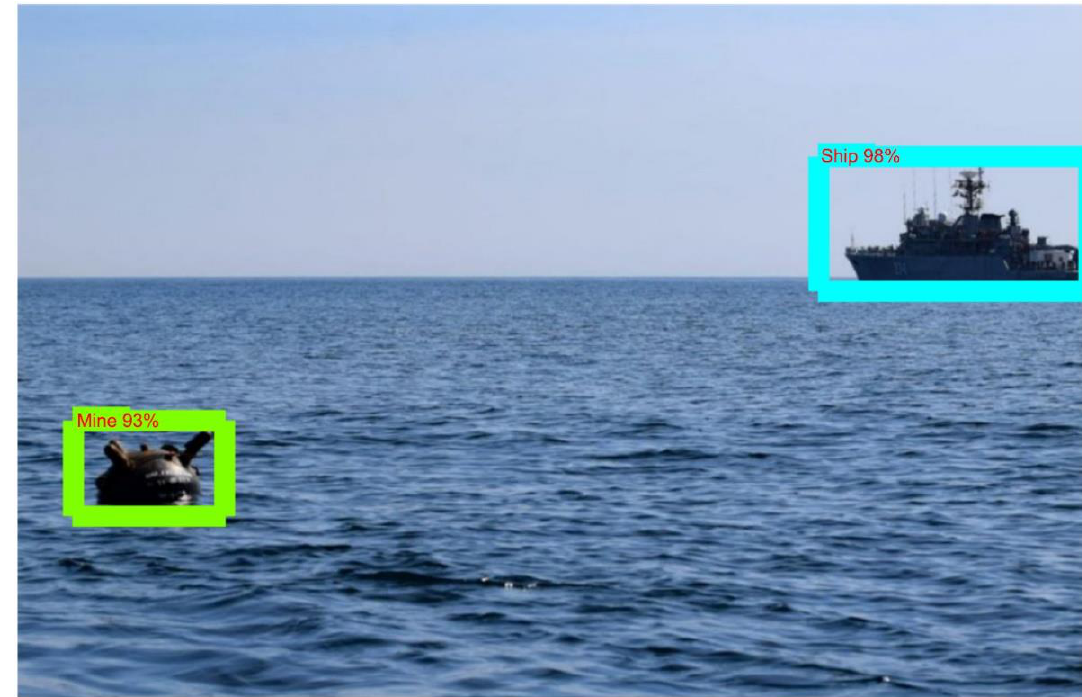
Figure 17. SSD floating mine detection.